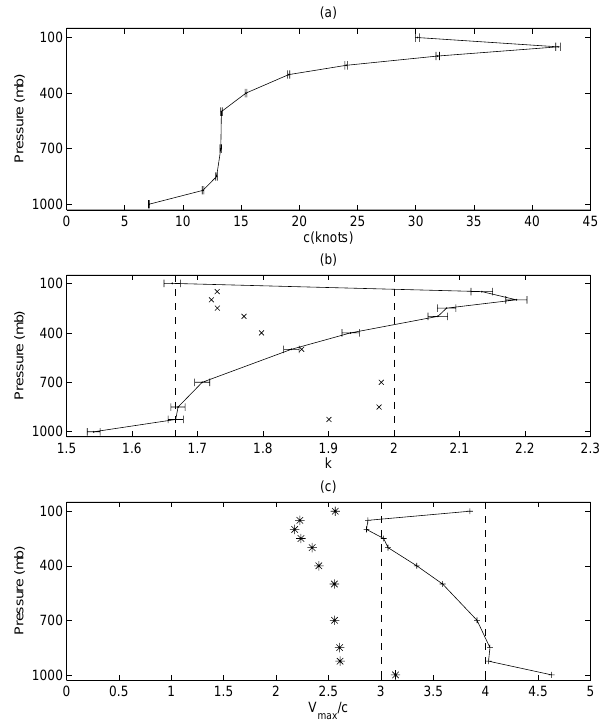
Fig. 3. Plots of empirically fitted attributes of the Weibull distri- bution for wind speed at different pressure levels in MP: (a) scale parameter c ; (b) shape parameter k , (c) scaled threshold v max /c for wind speed. Error bars for c and k are estimated by MLE at 95% confidence level. Vertical dashed lines correspond to k = 5 / 3, 2 in (b) and v max /c = 3, 4 in (c) . Crosses in (b) denote theoretical lower bound for k for wind anomaly magnitude. Asterisks in (c) denote the threshold v m3sd (mean plus three standard deviations) at each pressure